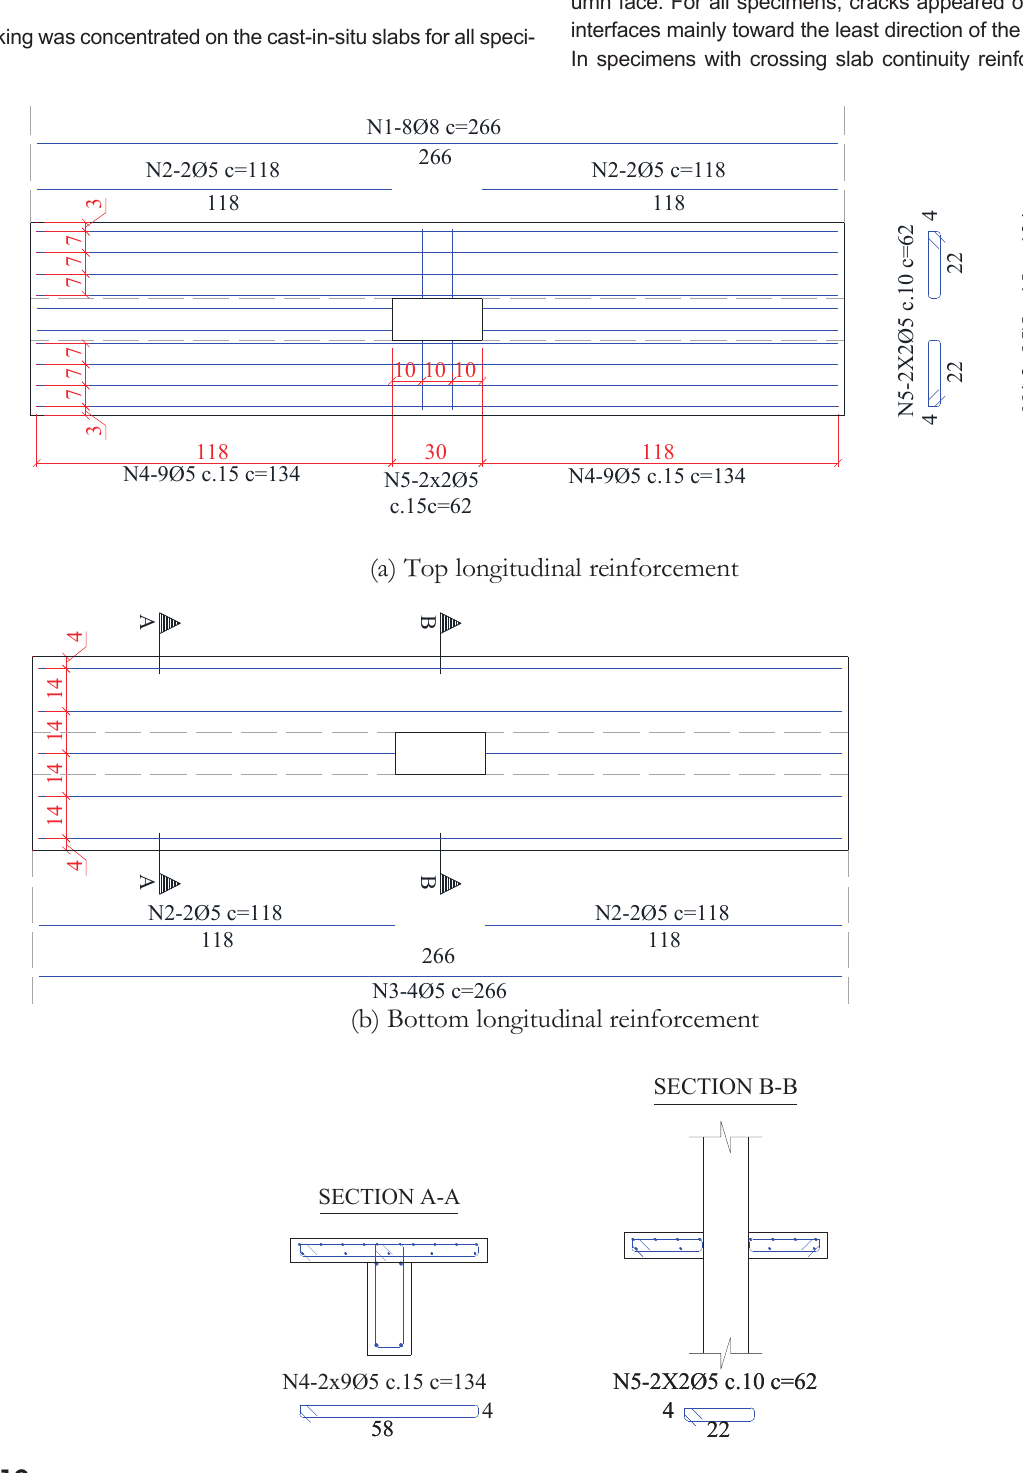
Figure 10 – Details of the slabs: specimens LC and LS (length dimensions in Details of the slabs: specimens LC and LS (length dimensions in cm)